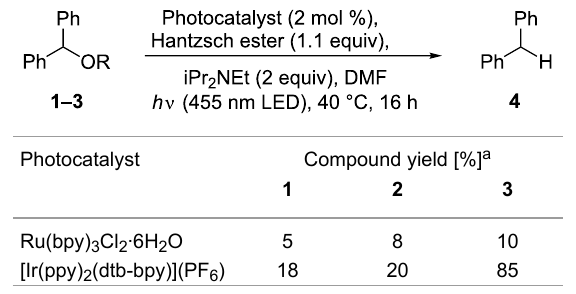
Table 1: Comparison of different esters and photocatalysts in deoxy- genation reaction.